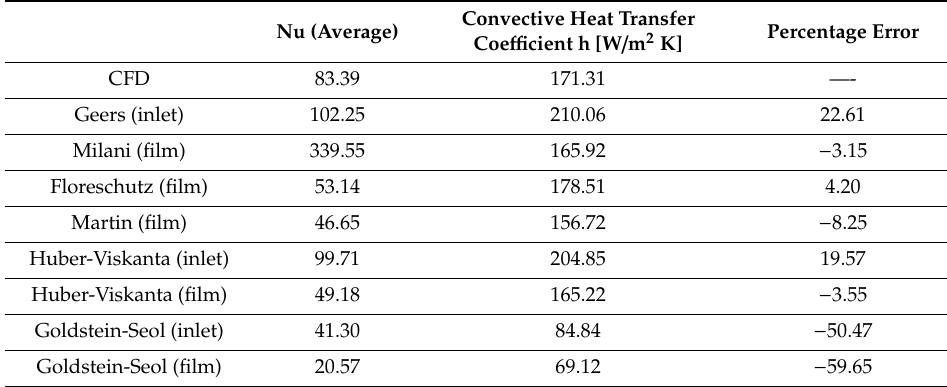
Table 3. Comparison of numerical results and numerical correlations